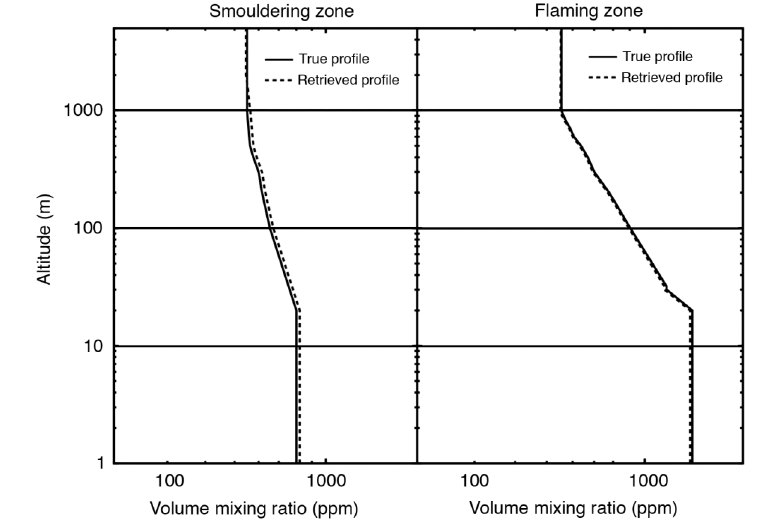
Fig. 8. Retrieval results for the «5% flaming zone» case: CO 2 profiles for the flaming and the smouldering